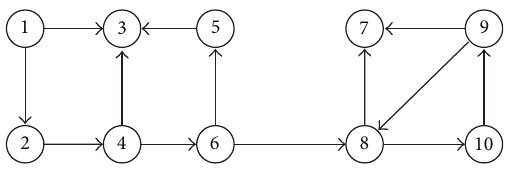
Figure 1: A digraph with ten nodes.